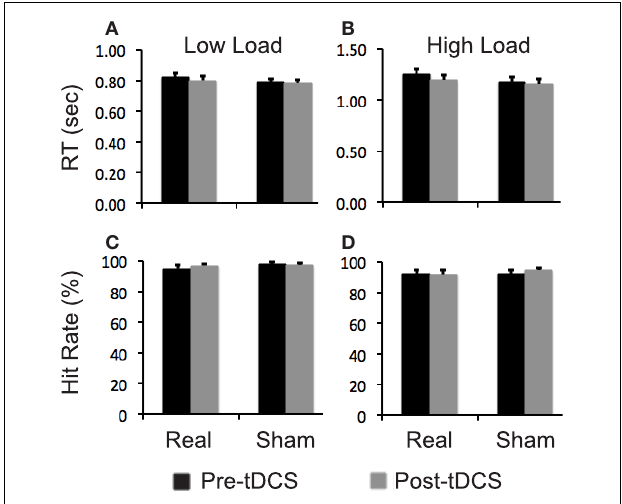
FIGURE 4 |Task performance data . Bar graphs show reaction time (RT) and hit rates on the visual attention task. (A,B) RT at low and high task load condition, respectively; (C,D) hit rates at low and high task load condition, respectively. Error bars indicate standard error of means (SEs).